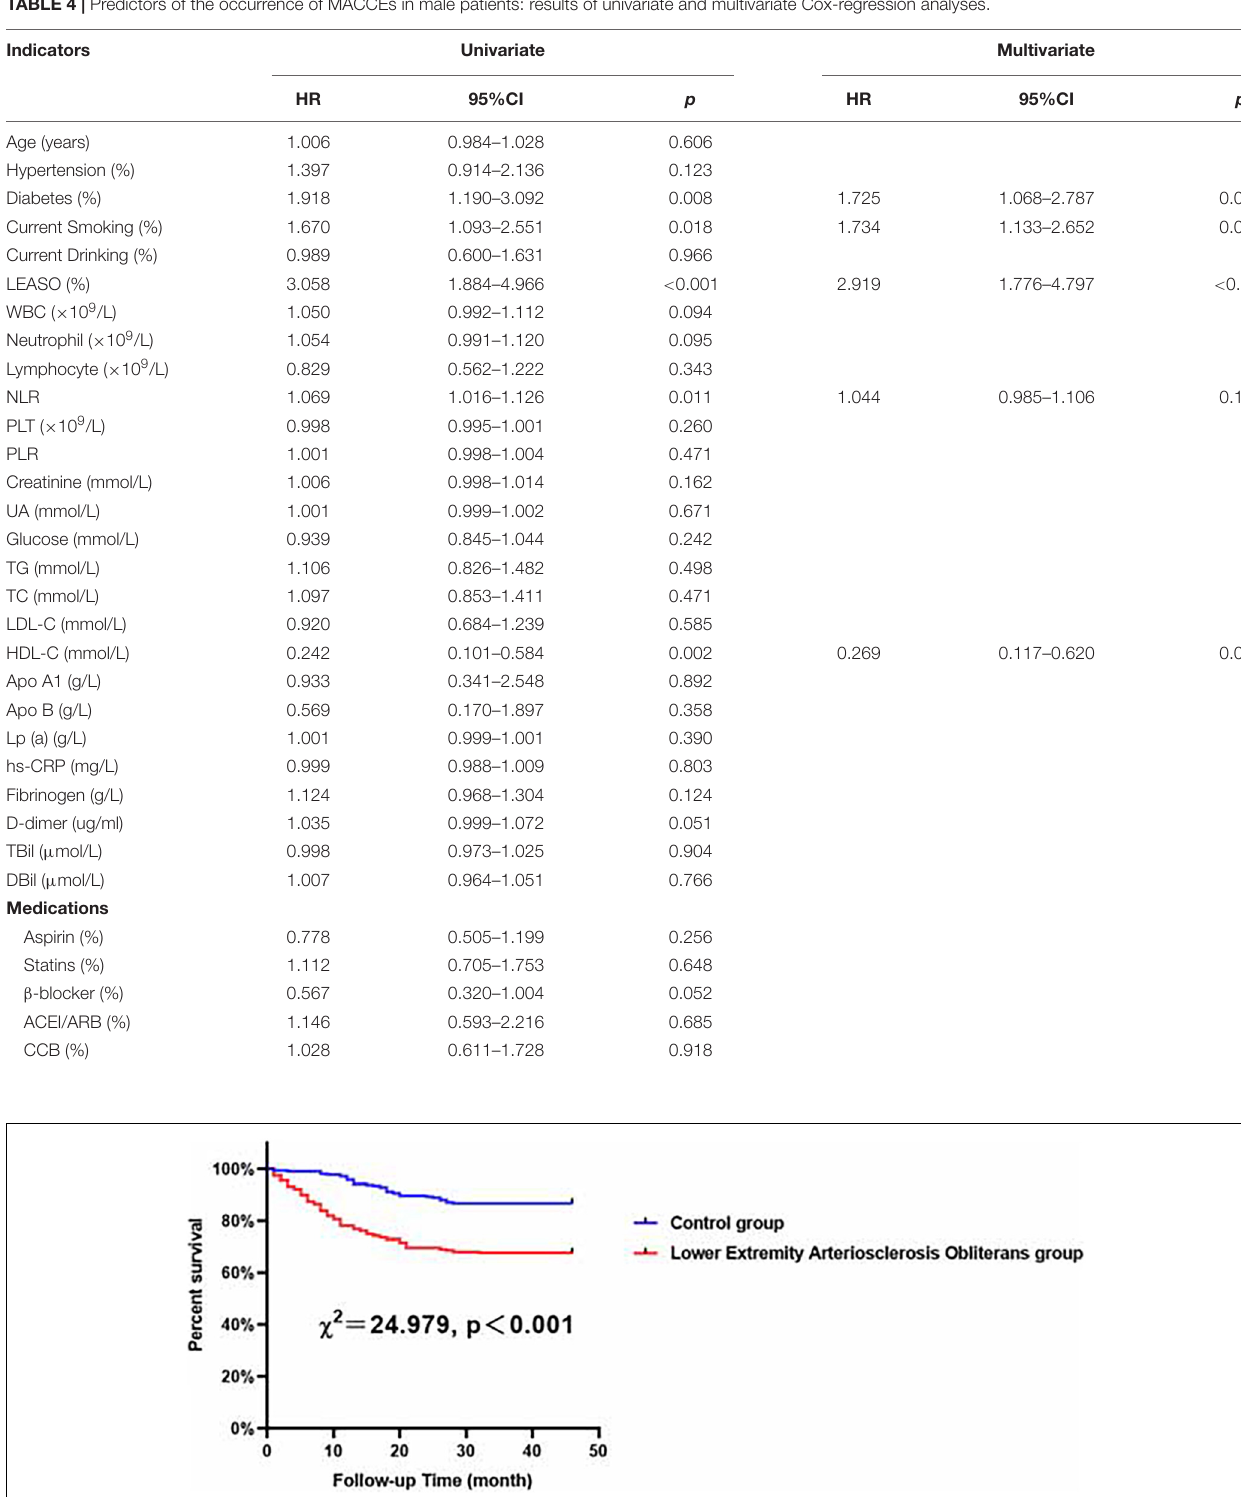
Frontiers in Cardiovascular Medicine |